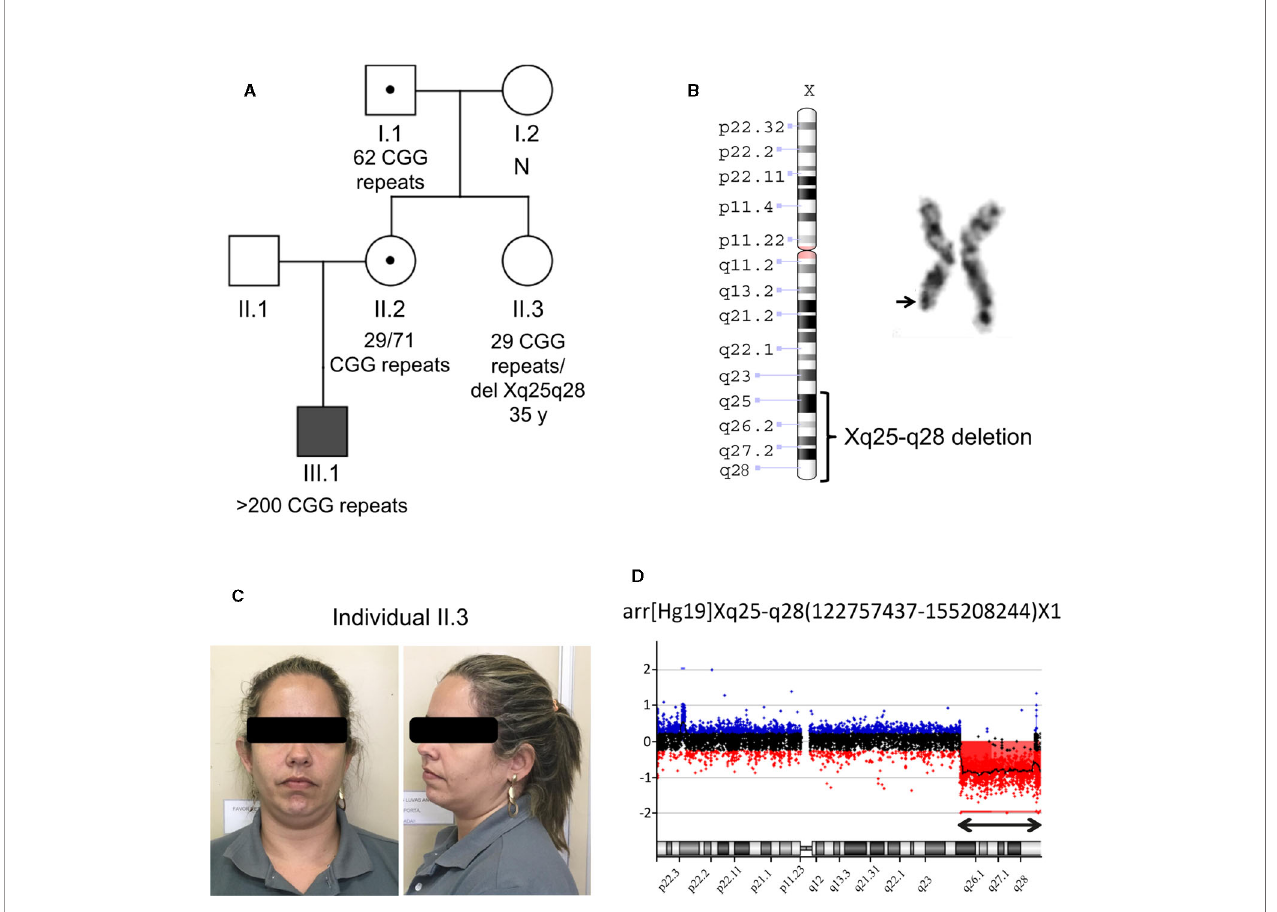
FIGURE 1 | Molecular and cytogenetics analysis in the studied family. (A) Family pedigree showing the segregation of the FMR1 CGG repeat expansion that was ascertained through the proband with ID (individual III.1 indicated by a solid square). Open squares represent unaffected males and open circles represent unaffected females. Circle or square with a black dot represents an unaffected carrier female or male, respectively. “ N ” indicates no FMR1 expansion. A heterozygous Xq25-q28 deletion is present in the individual II.3; (B) Partial G banded karyotype from the individual II.3 and ideogram of the Xq deleted region. (C) Pictures of the individual II.3 that harbors the Xq25-q28 deletion; (D) X-chromosome array-CGH analysis plot from the individual II.3. Cy3-labeled DNA of the individual II.3 was co-hybridized with Cy5-labeled DNA from a control onto the array. The double arrow points to the deletion of subsequent probes. Note that the deletion is seen as an increased Cy5/ Cy3